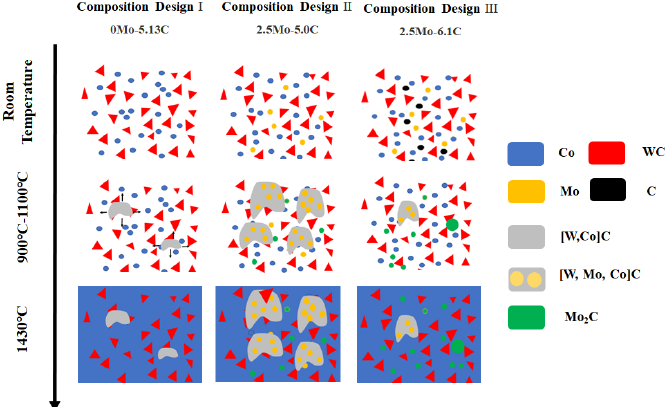
Figure 13. The reaction diagram in the heating process of sintering in WC-Co cemented carbides adding different contents of Mo and C.